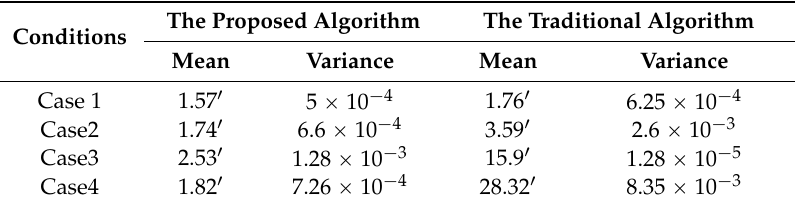
Table 3. Statistics of heading errors based on the open-loop Kalman filter (KF).